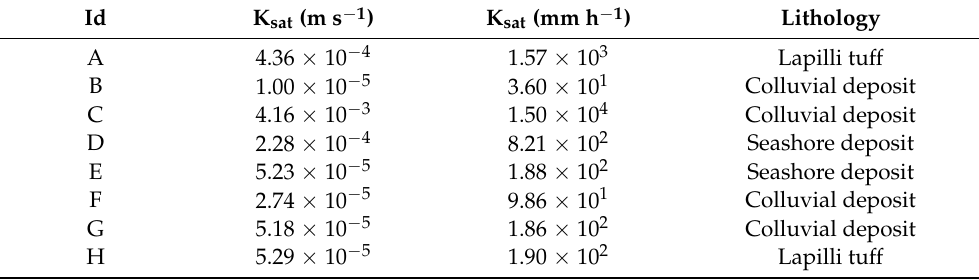
Table 1. Values of hydraulic conductivity under saturated conditions (K sat ), normalized at 10 ◦ C, measured in Stromboli samples (Figure 2 for